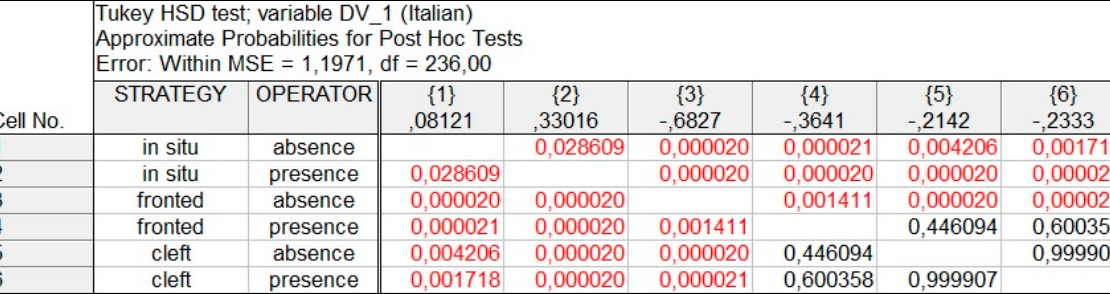
Figure 21. Strategy*Operator post hoc results (Italian) .